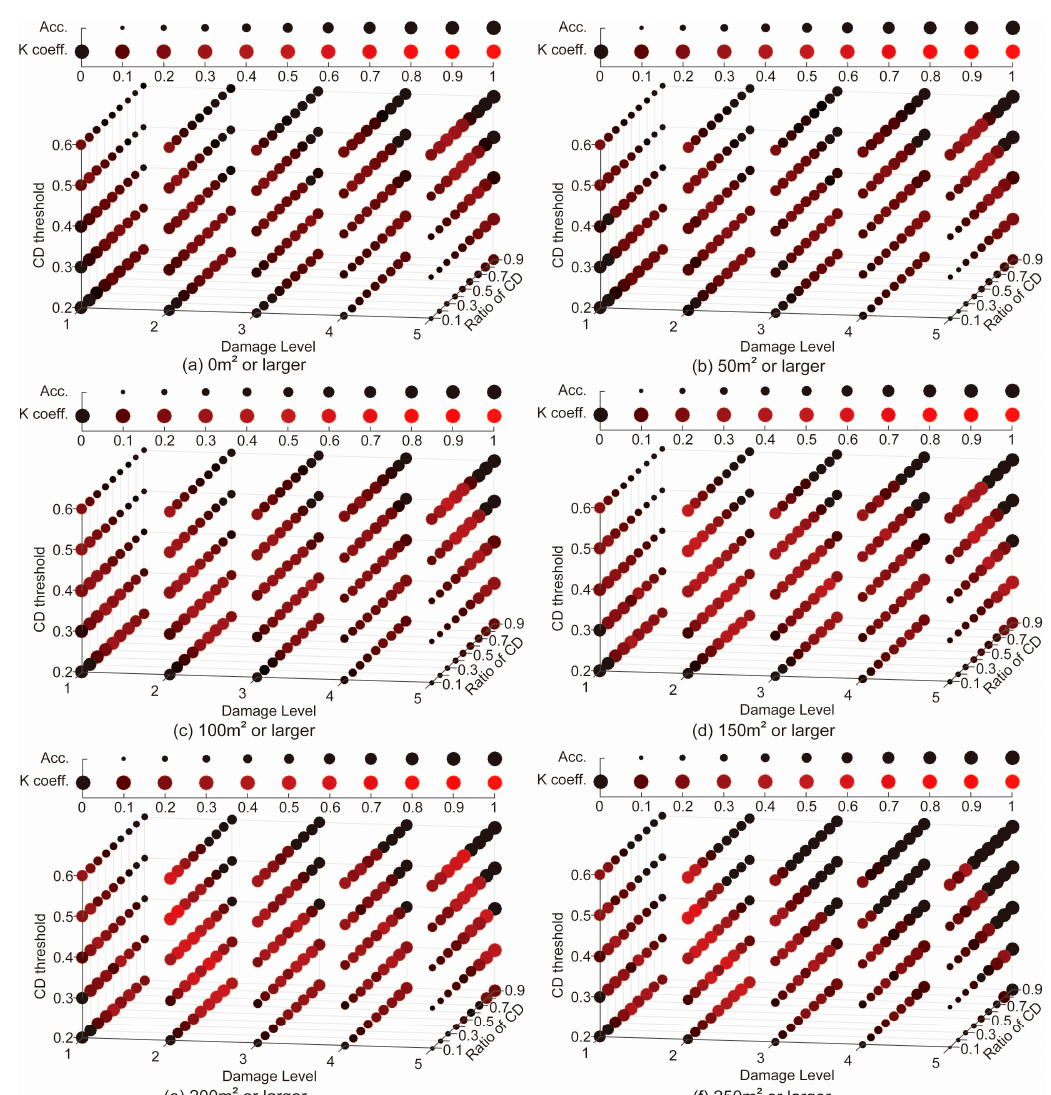
Figure 7. Full search results for the overall accuracy and Cohen’s Kappa coefficient among multiple DLs (right to left), CD threshold (up to down), and ratio of CD (forward to backward). ( a – f ) Building threshold of 0 m 2 –250 m 2 with 50 m 2 intervals. The larger dot indicates the higher accuracy and the brighter red dot shows the higher K coefficient. Table 3. Overall accuracy and Cohen’s Kappa coefficient for coherence analysis with buildings over 200 m 2 and with DL 2 or greater. Bold numbers with gray background represent the cells which accuracy and K-coefficient are over 0.7 and 0.4 respectively.